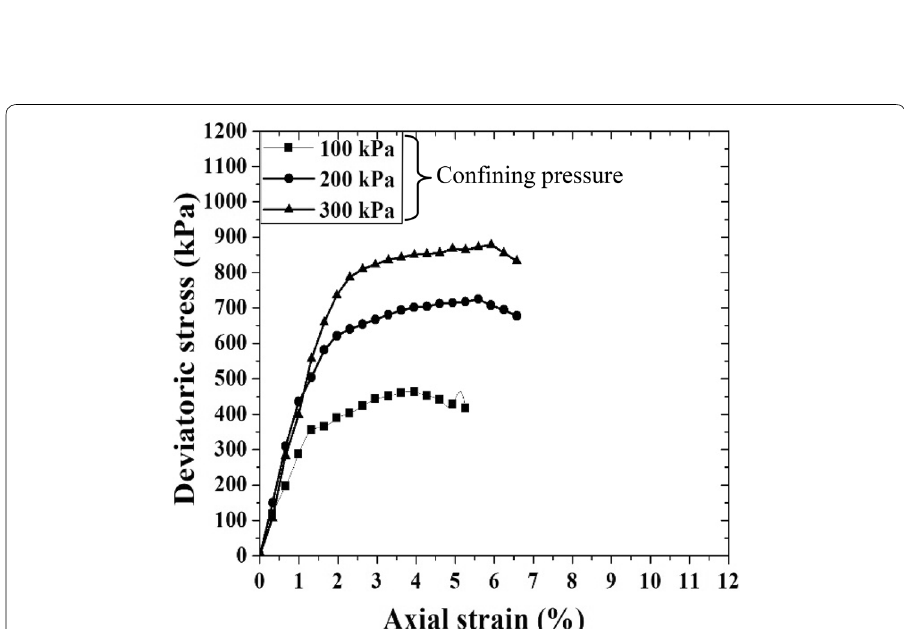
Fig. 23 Stress strain behavior of KTPS bottom ash at